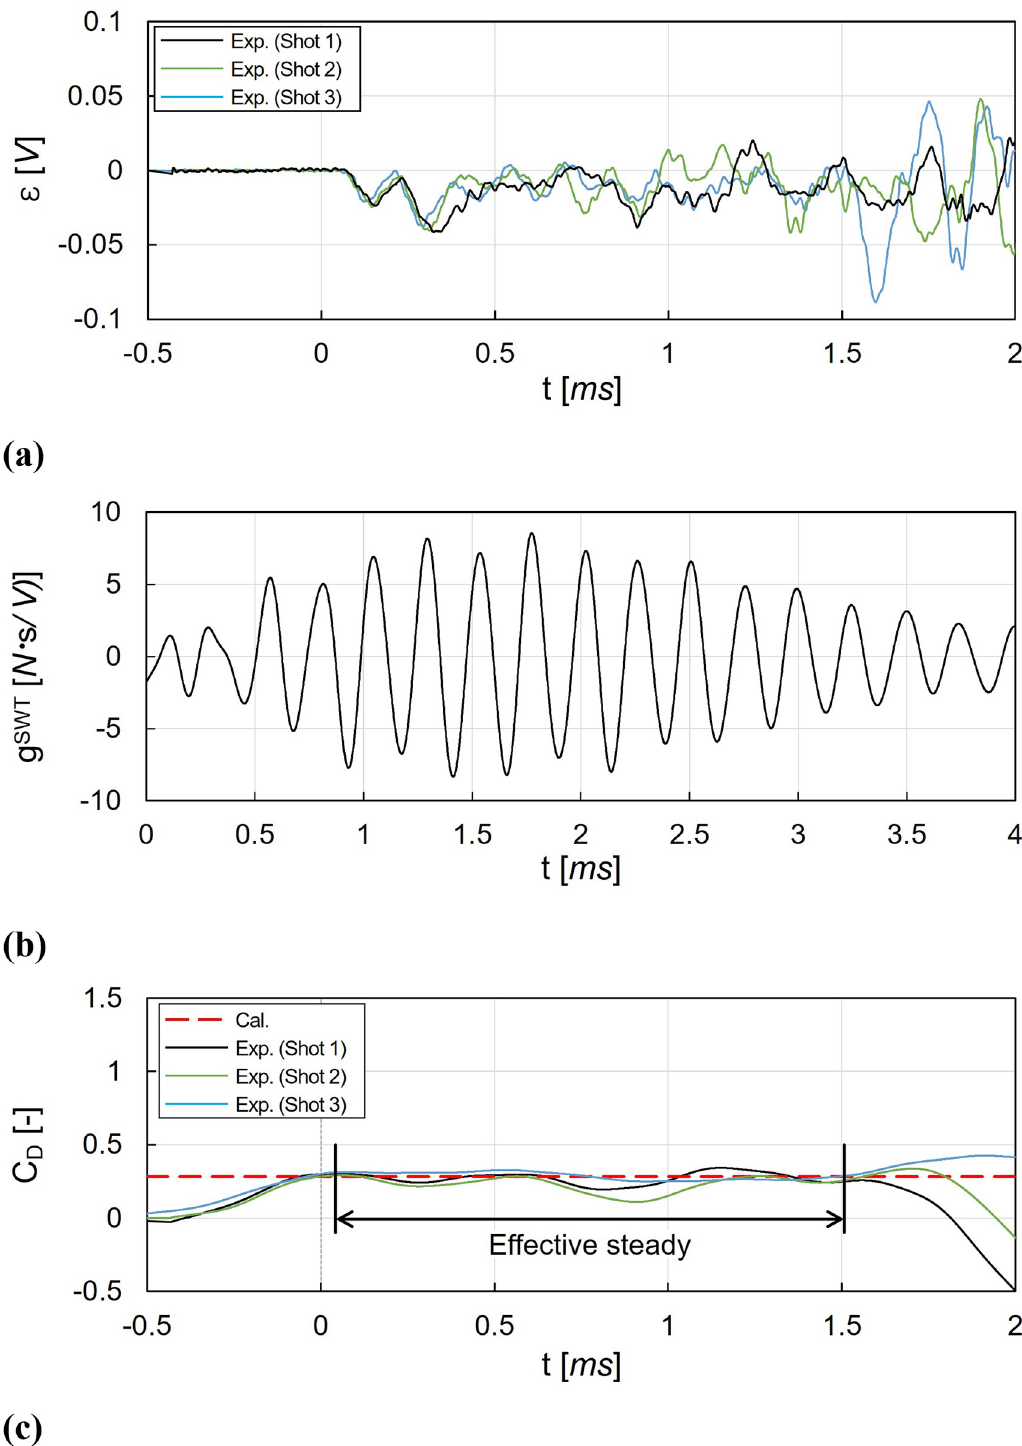
Fig 13. Drag coefficient measurements using the SWT. (a) Measured strain, (b) Dynamic response function of the SWT for 4.0 ms ., (c) Recovered drag coefficient